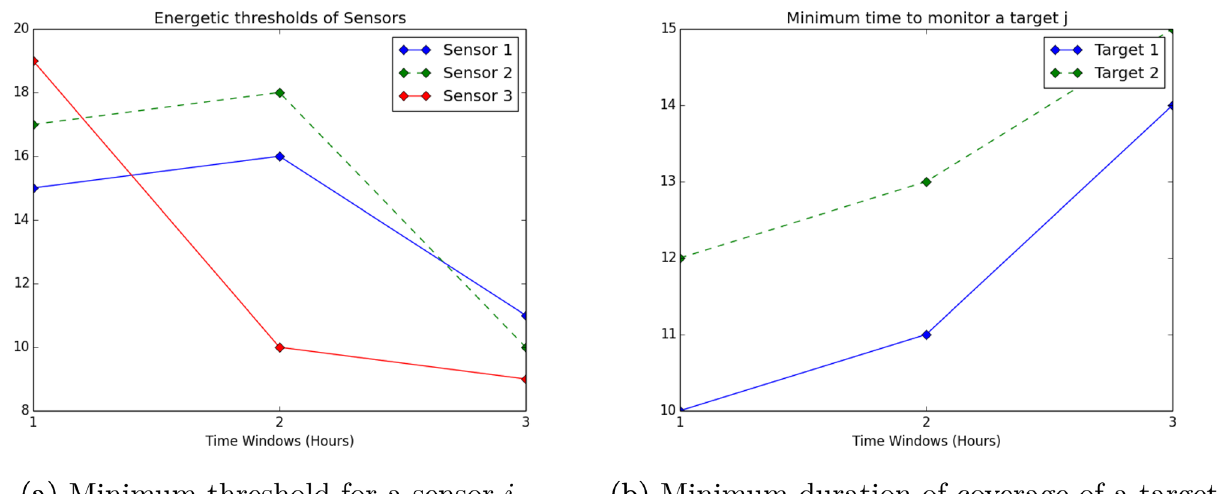
Fig. 7 Scheduling of sensors and targets in each mission m